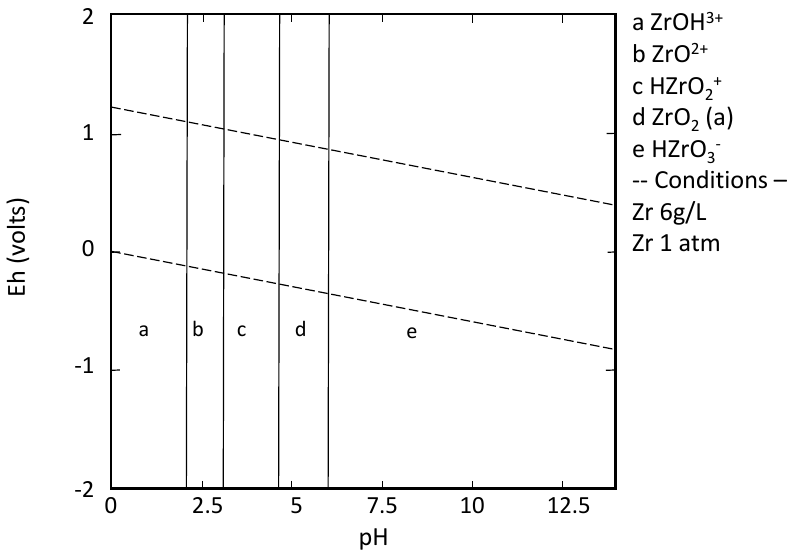
Figure 5. EpH diagram of Zr dependent of pH calculated by StabCal. Database used: Helgeson (SupCrt).